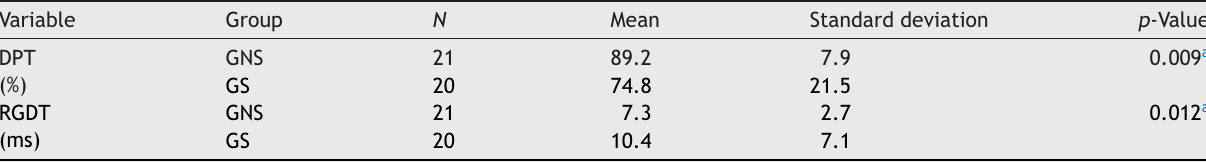
Descriptive measures of the DPT (%) and RGDT (ms) responses in the GNS and GS groups. Variable